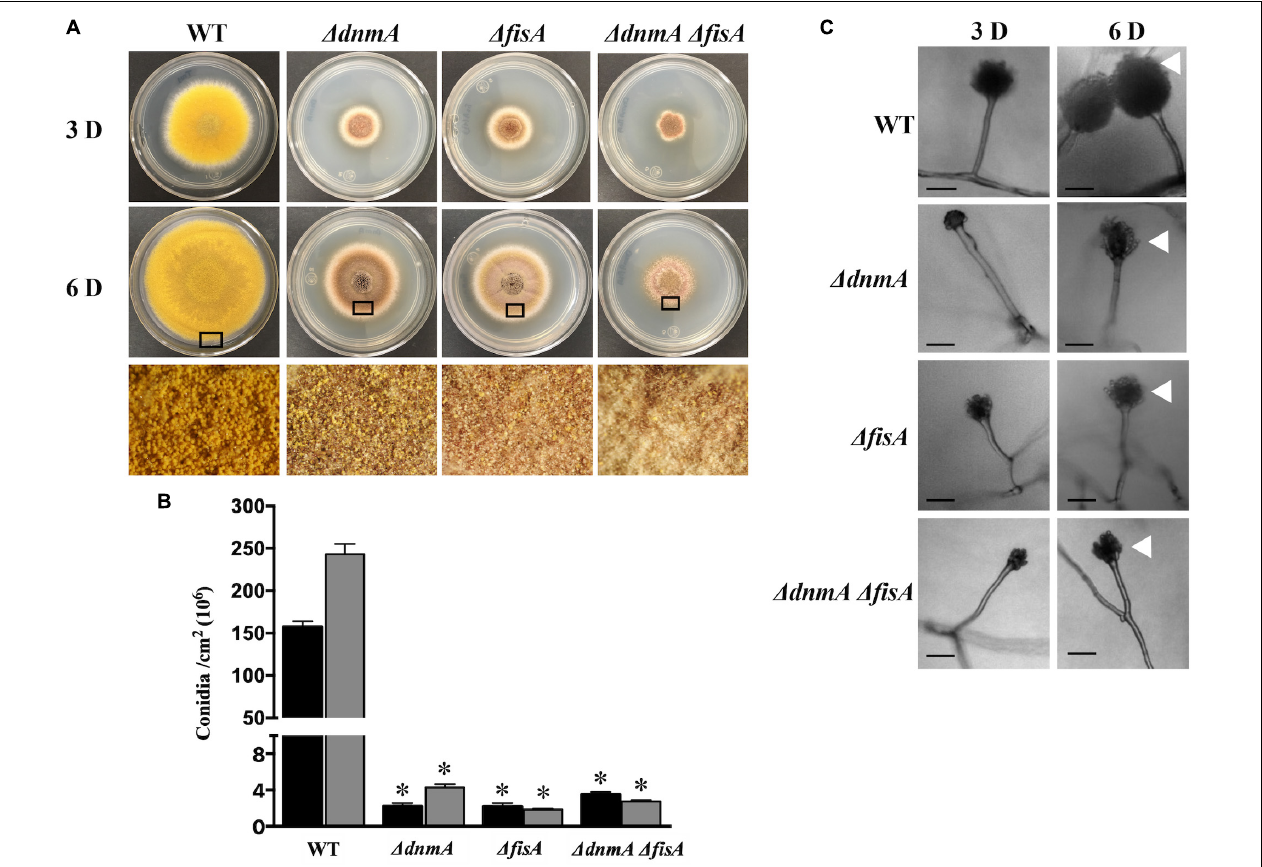
FIGURE 1 | dnmA and fisA genes are required for normal growth and asexual development. (A) Conidia (1x10 4 ) from strains TRV1 (WT), CVG1 ( (cid:49) dnmA ), CVG2 ( (cid:49) fisA ), and CVG3 ( (cid:49) dnmA (cid:49) fisA ) were inoculated on supplemented MM plates and incubated at 37 ◦ C for 3 (upper panel) or 6 (middle panel) days (D). Lower panels show enlargements from 6-day colony borders. (B) Total conidiospores per colony were harvested, counted and the count divided by colony area to determine number of conidia per square centimeter. Black and gray bars represent 3 D and 6 D spore numbers, respectively. Standard deviation from three independent experiments is indicated. Data analyzed by one-way ANOVA, following Tukey’s test ( ∗ p < 0.05). Asterisks indicate significant differences with respect to the WT strain. (C) Conidiophores from the indicated strains were obtained from 3 and 6-day colonies and observed under the microscope. White arrowheads point to conidiophore heads. Black bars = 20 µ